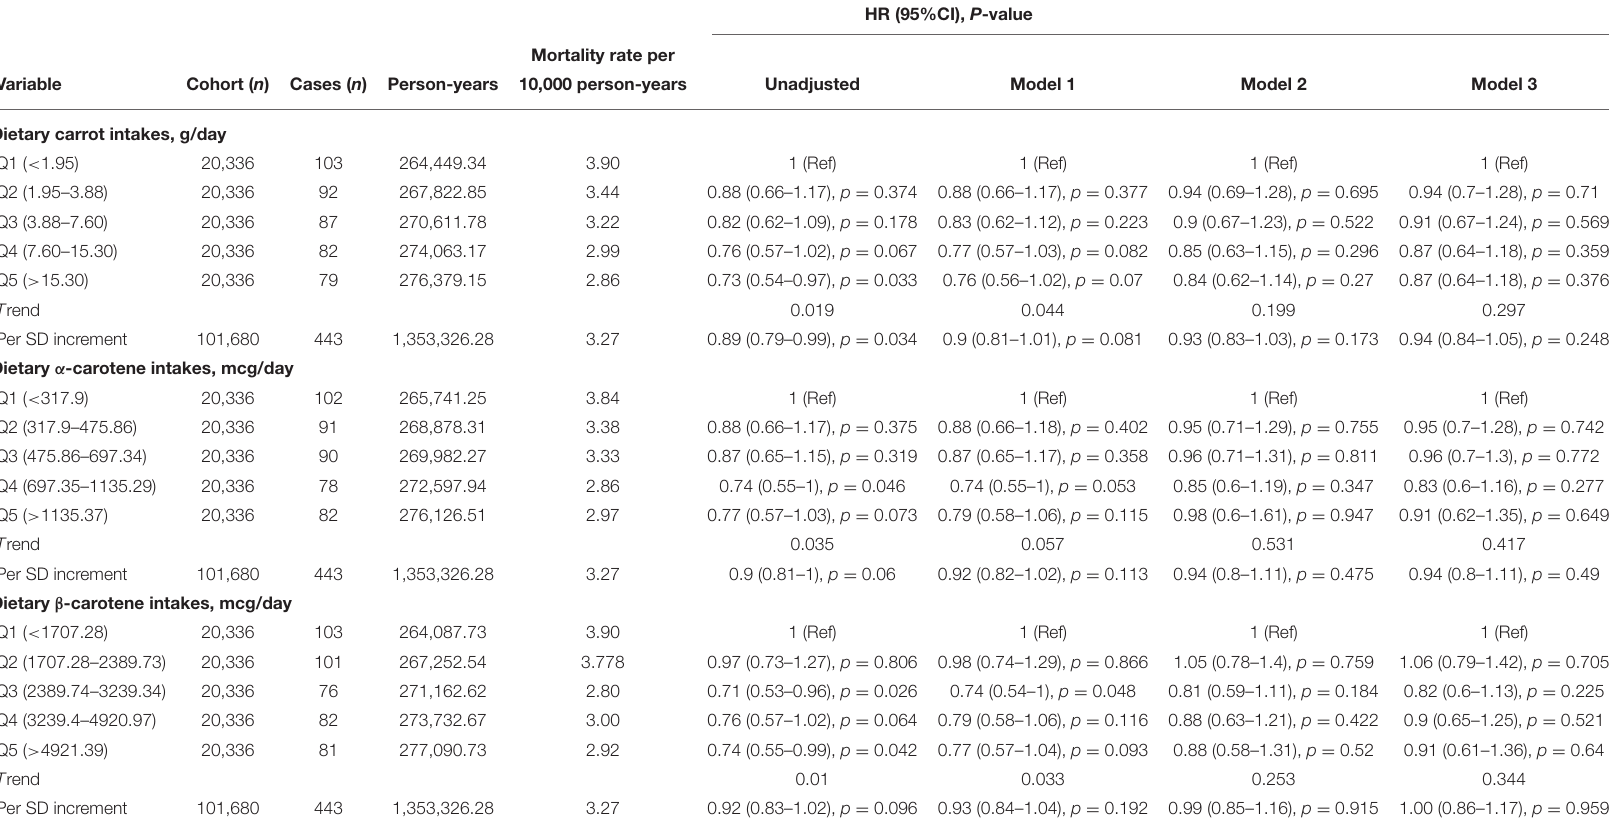
TABLE 3 | Association between energy-adjusted dietary carrot/carotene intakes and colorectal cancer mortality risk in the PLCO cancer screening trial.